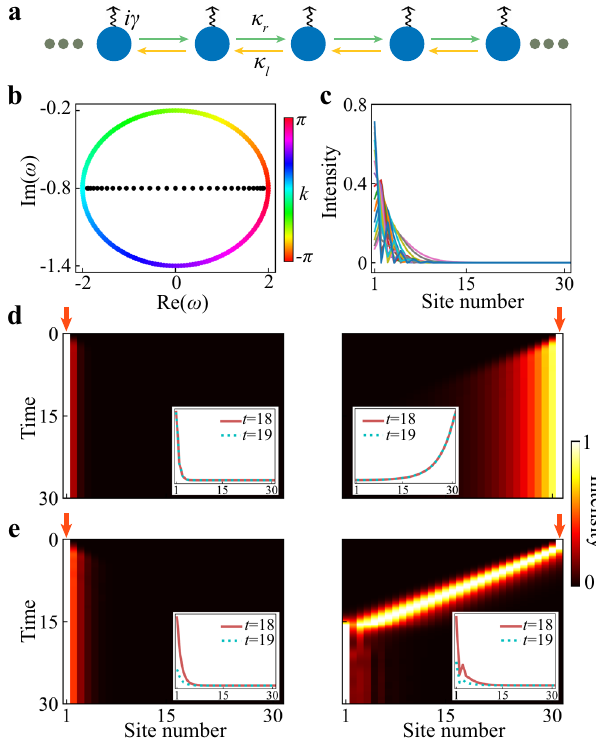
Fig. 2 | Numerical results for the 1D tight-binding model. a Schematic of the lattice, where γ denotes the on-site loss and κ r ( κ l ) are couplings from left to right (right to left). b The eigen spectra for the lattice shown in ( a ) under PBC (colored dots) and OBC (black dots), respectively. c Plot of all eigenmodes under OBC for a fi nite lattice with 31 sites. d Time evolutions of the intensity fi eld in a fi nite lattice with a monochromatic excitation ( ω =0.5) at the left end (left panel) and the right end (right panel). e Similar to ( d ) but for a complex-frequency excitation ( ω =0.5+0.6 i ). d , e The intensity ateach time slice is normalized by the maximum value atthatmoment for easy visualization and theinsets show the signalstrength without normalization at t =18 and t =19. The lattice parameters used in the cal- culations are κ r =0.7, κ l =1.3, and γ